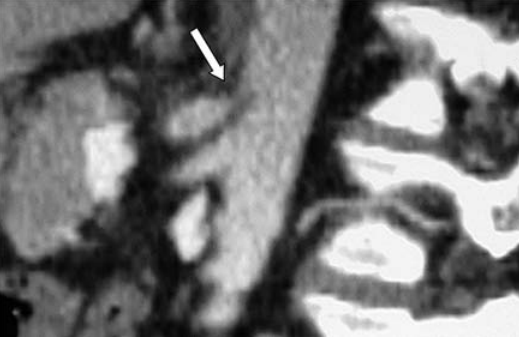
Figure 1 Spiral CT